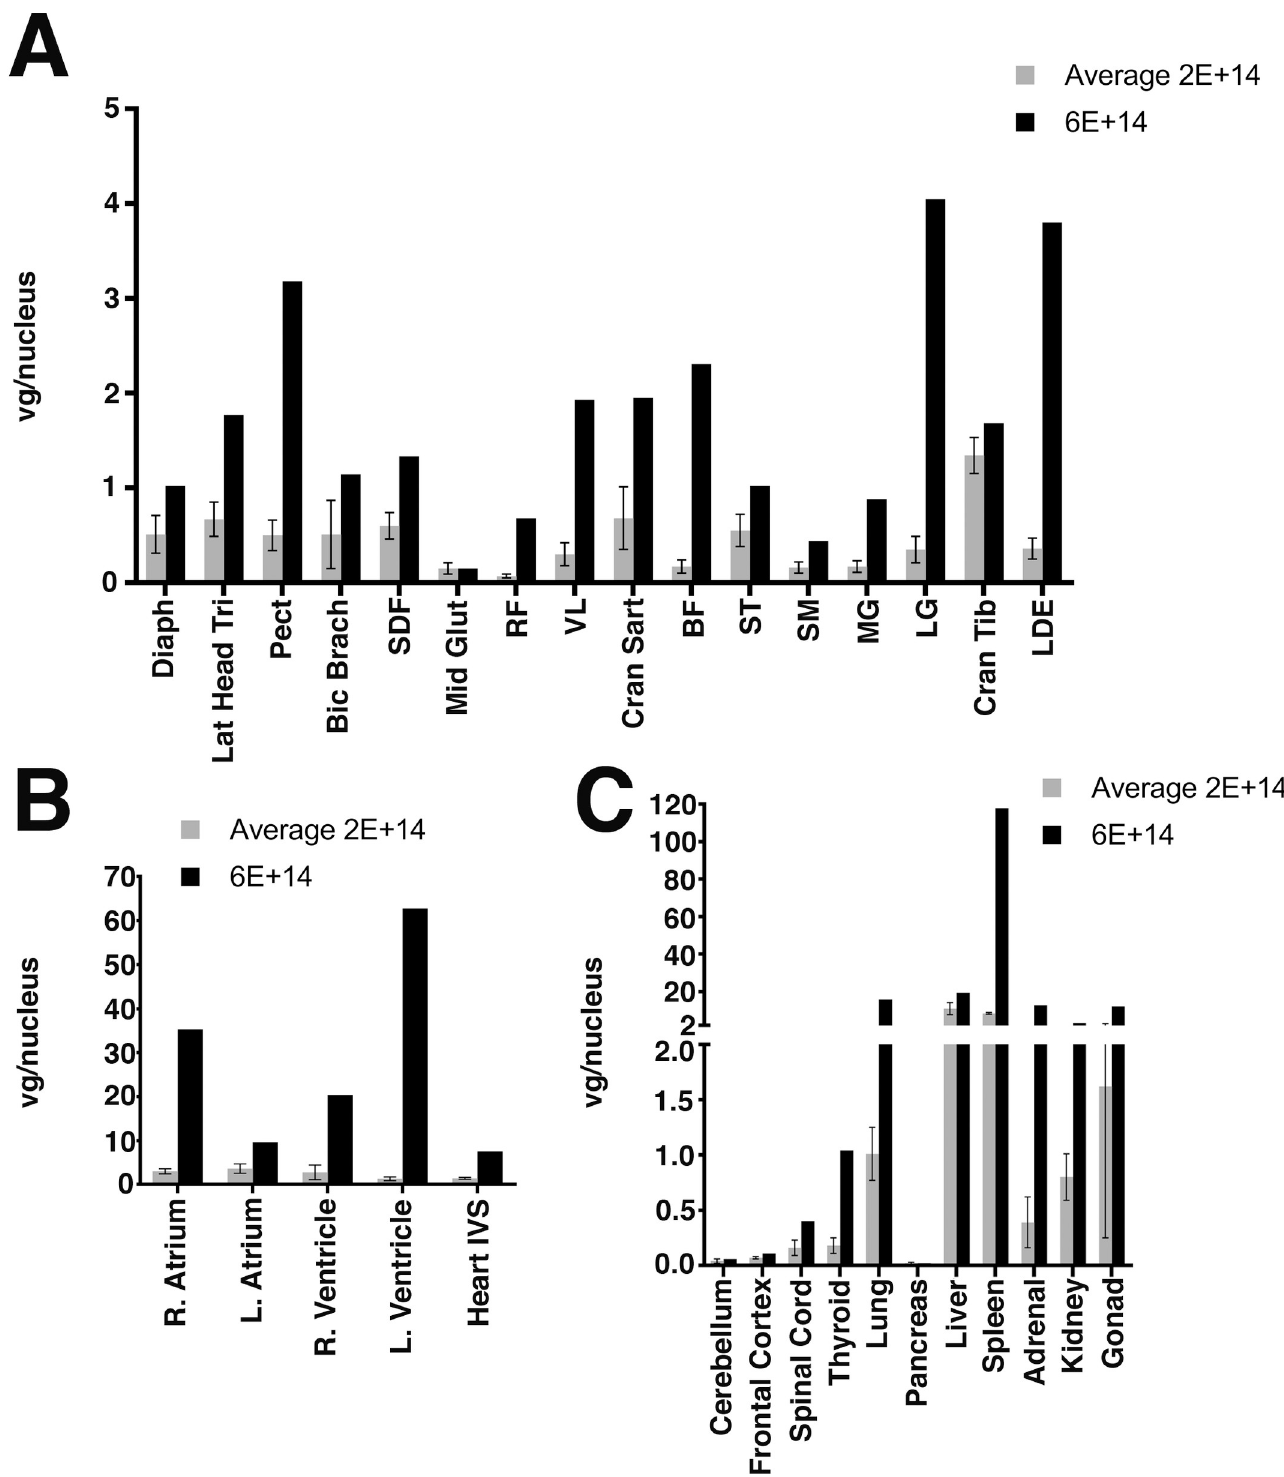
Fig 1. Biodistribution of AAV genomes in muscles and non-muscle organs after rAAVrh74.MHCK7. GALGT2 treatment of GRMD dogs. rAAV vector genomes were measured in skeletal muscles (A), heart (B), and non-muscle organs (C) by qPCR. Four GRMD dogs were dosed with 2x10 14 vg/kg (2E+14), with average transduction levels shown (lighter bars), while one GRMD dog was dosed with 6x10 14 vg/kg (black bars, 6E+14). Abbreviations: Diaph (Diaphragm), Lat (Lateral) Head Tri (Triceps), Pect (Deep Pectoral), Bic Brach (Biceps Brachii), SDF (Superficial Digital Flexor), Mid Glut (Middle Gluteal), RF (Rectus Femoris),